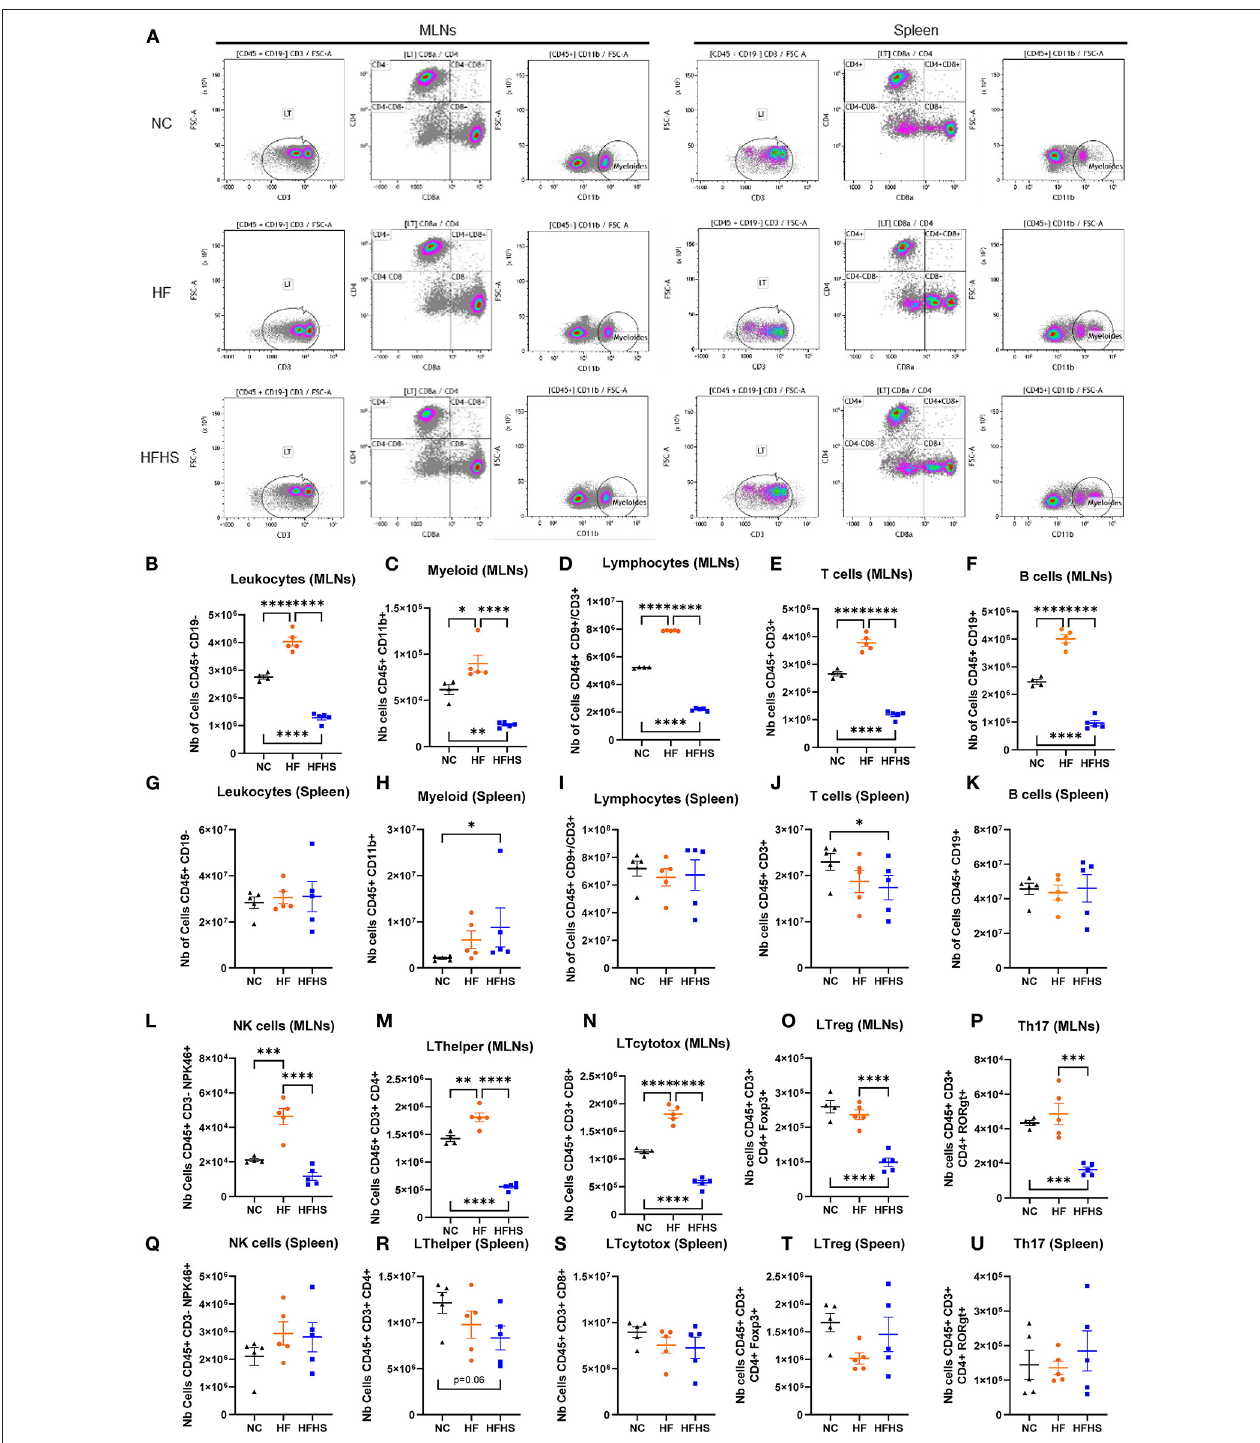
FIGURE 2 | Sucrose repressed immune cell levels in mesenteric lymph nodes and spleen. (A) Representative flow cytometry recording mesenteric lymph nodes (MLNs) and spleen. (B–U) Relative abundance of indicated immune cell populations MLNs or spleen for mice fed with normal chow diet (NC, N = 5), high-fat diet (HF, N = 5), or high-fat high-sucrose (HFHS, N = 5). Means + /- SEM are plotted. * p < 0.05, ** p < 0.01, *** p < 0.001, **** p < 0.0001 by ANOVA for parametric data or Kruskal-Wallis if not.